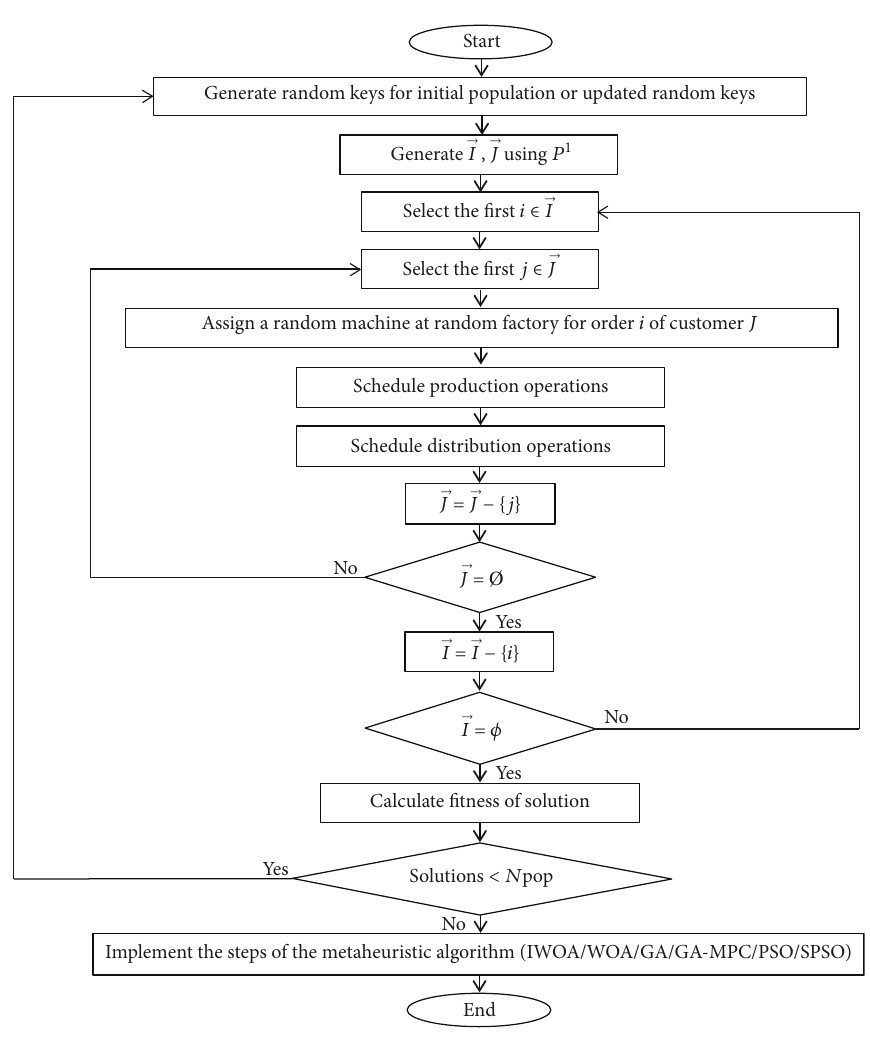
Figure 5: Simulation-based algorithm.